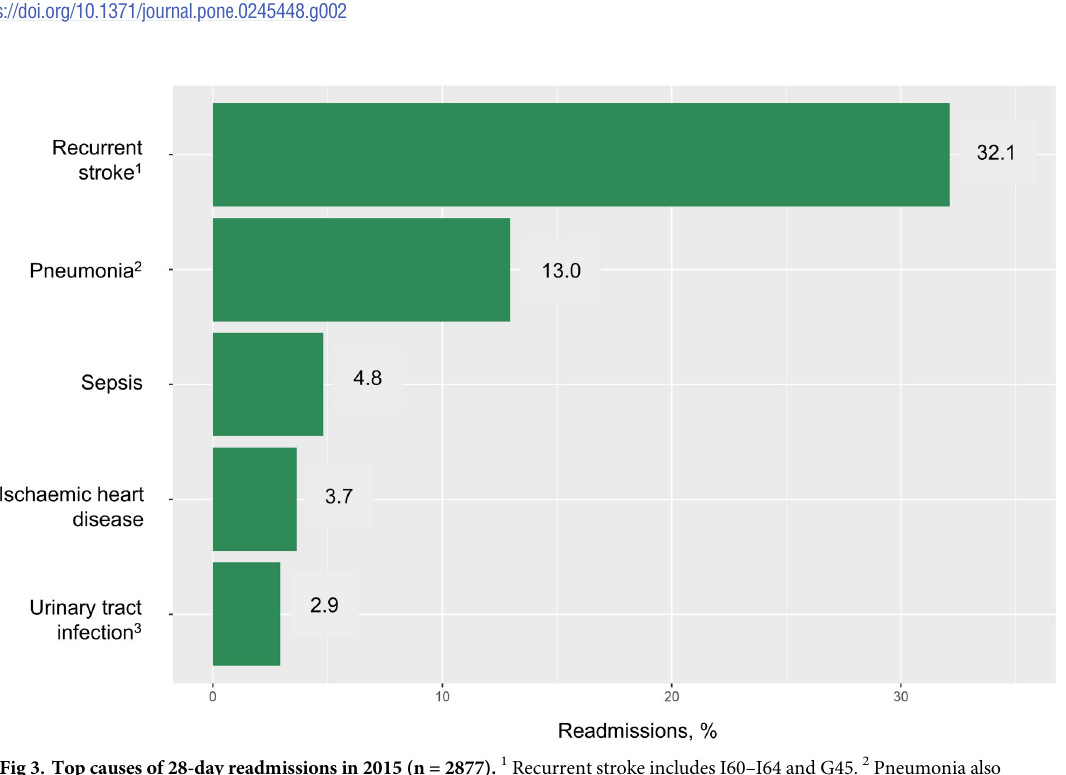
PLOS ONE | https://doi.org/10.1371/journal.pone.0245448 January 19,